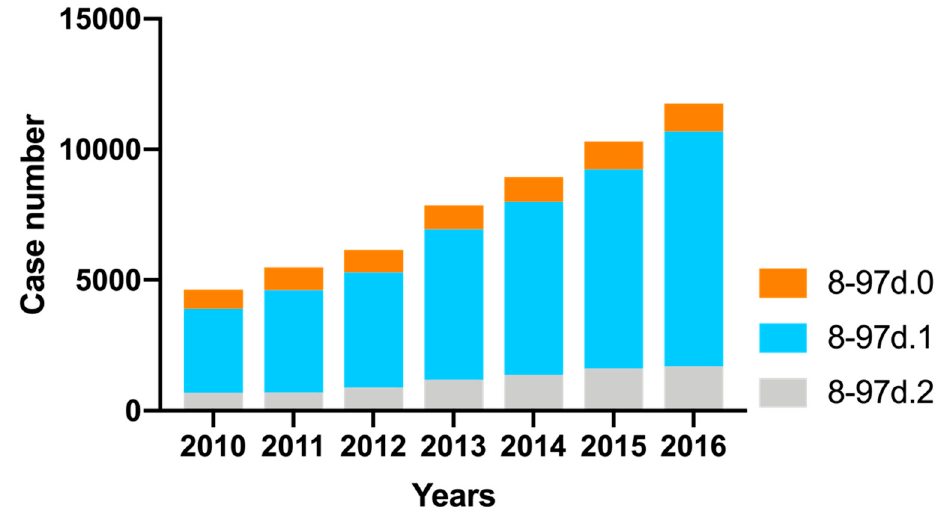
Figure 2. Case number development of PD-MCT from 2010 to 2016 divided into subcategories. 8–97d.0 = PD-MCT treatment of 7–13 days; 8–97d.1 = PD-MCT treatment of 14–20 days; 8–97d.2 = PD-MCT treatment of at least 21 days.